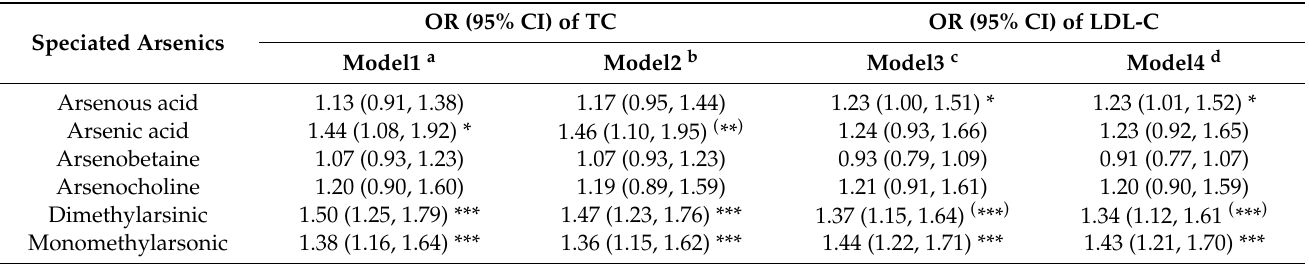
Table 6. Adjusted odds ratios (OR) and 95% confidence intervals (CI) of the association between TC and LDL-C and speciated